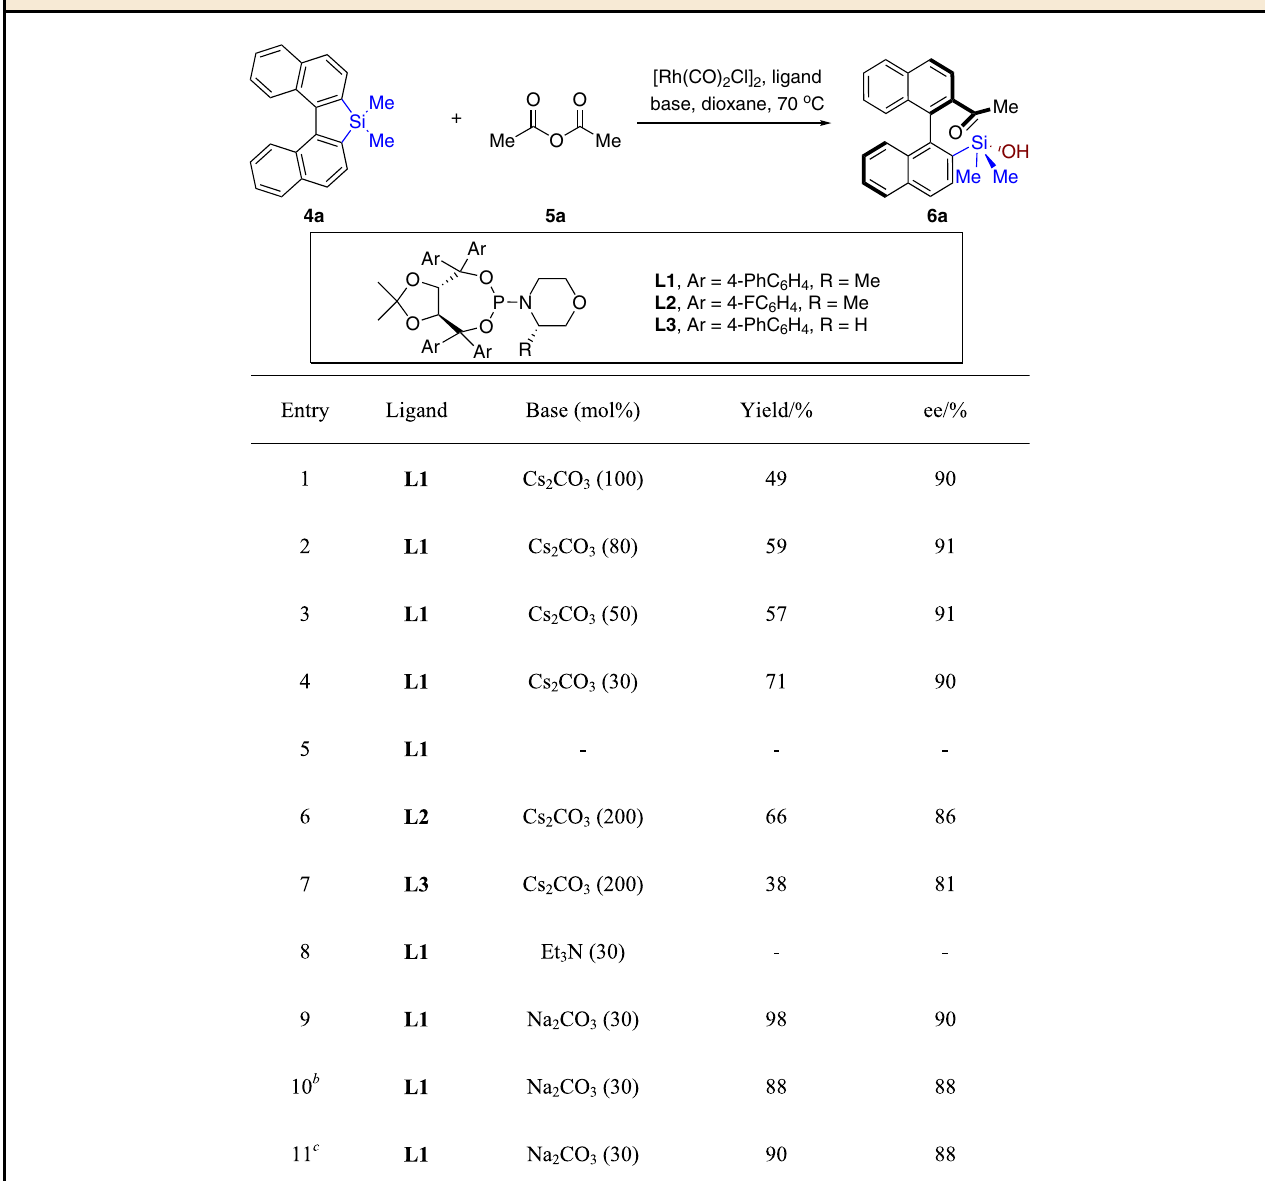
Table 1 Optimization of reaction conditions a